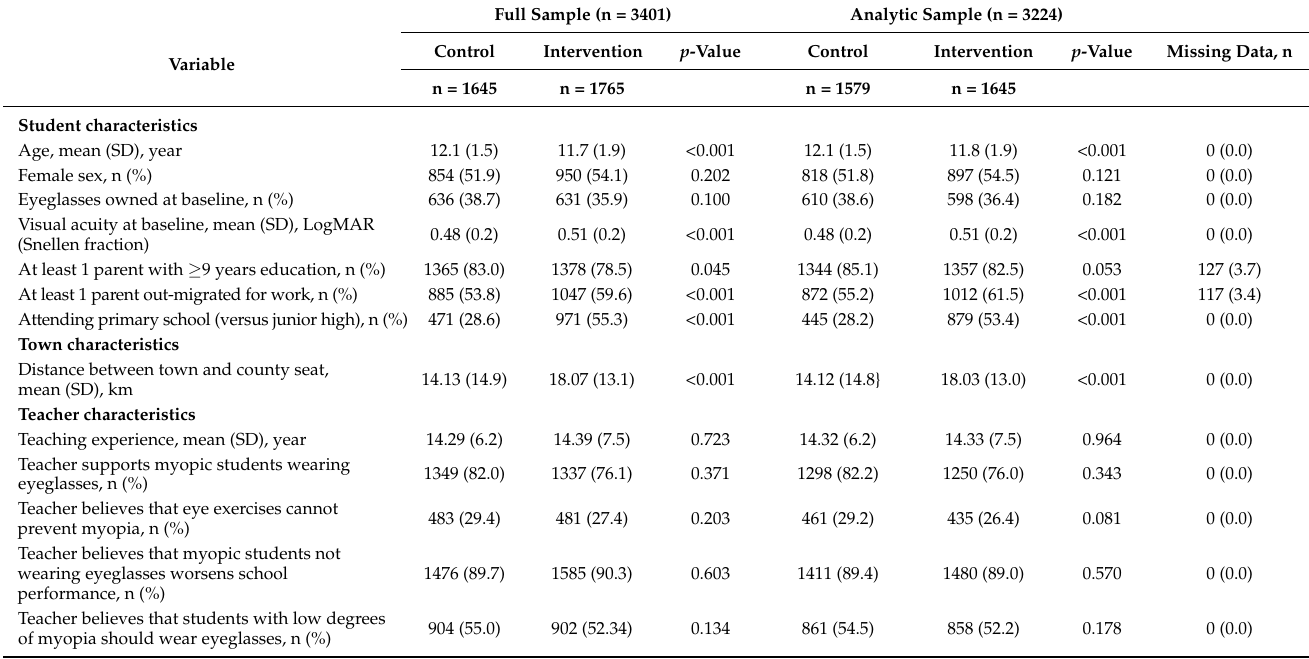
Table 1. Baseline characteristics of students with uncorrected refractive errors, by group assignment. Full Sample (n =